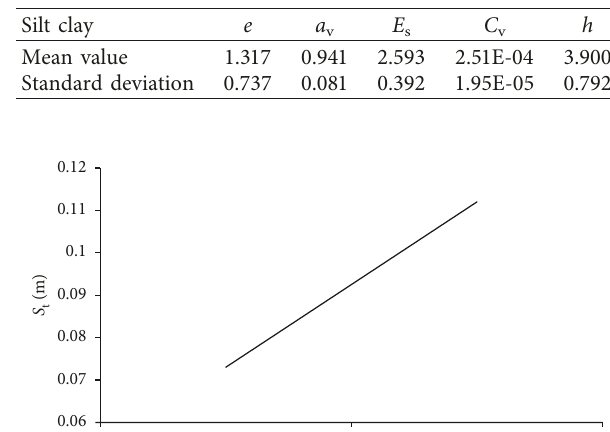
Table 1: The statistics of soil parameter.